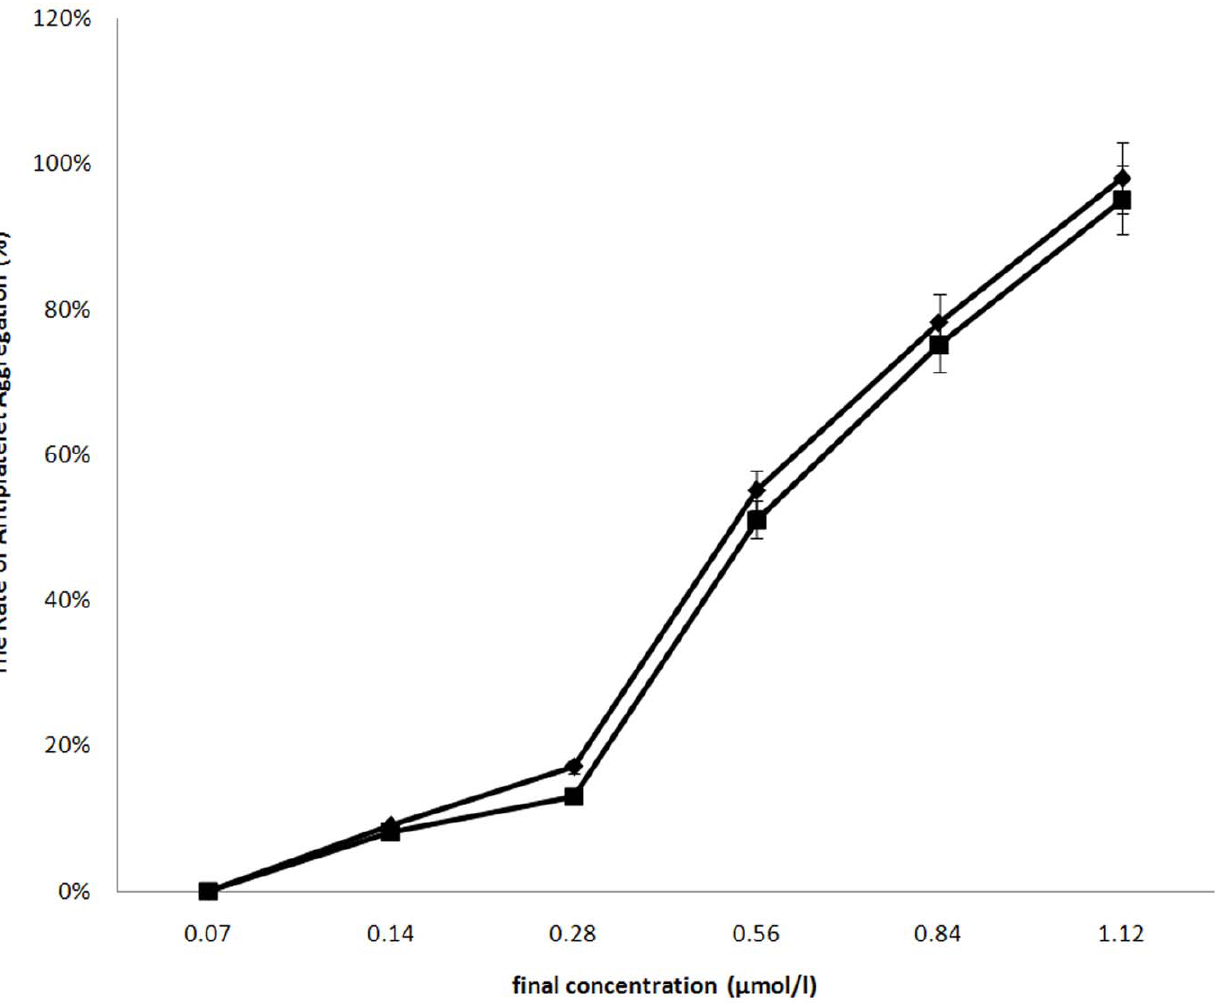
Figure 2. Unlabeled RGD-hirudin and 15 N, 13 C-labeled RGD-hirudin contains the similar effects on rabbit platelet-aggregation induced by ADP. ( ¤ ) unlabeled RGD-hirudin inhibited platelet aggregation induced by ADP in a dose-dependent manner; ( & ) 15 N, 13 C-labeled RGD-hirudin was same capable of inhibiting platelet aggregation induced by ADP; two samples 0.14 m mol/l could inhibit the platelet aggregation, and their inhibitory effect on the platelet aggregation were